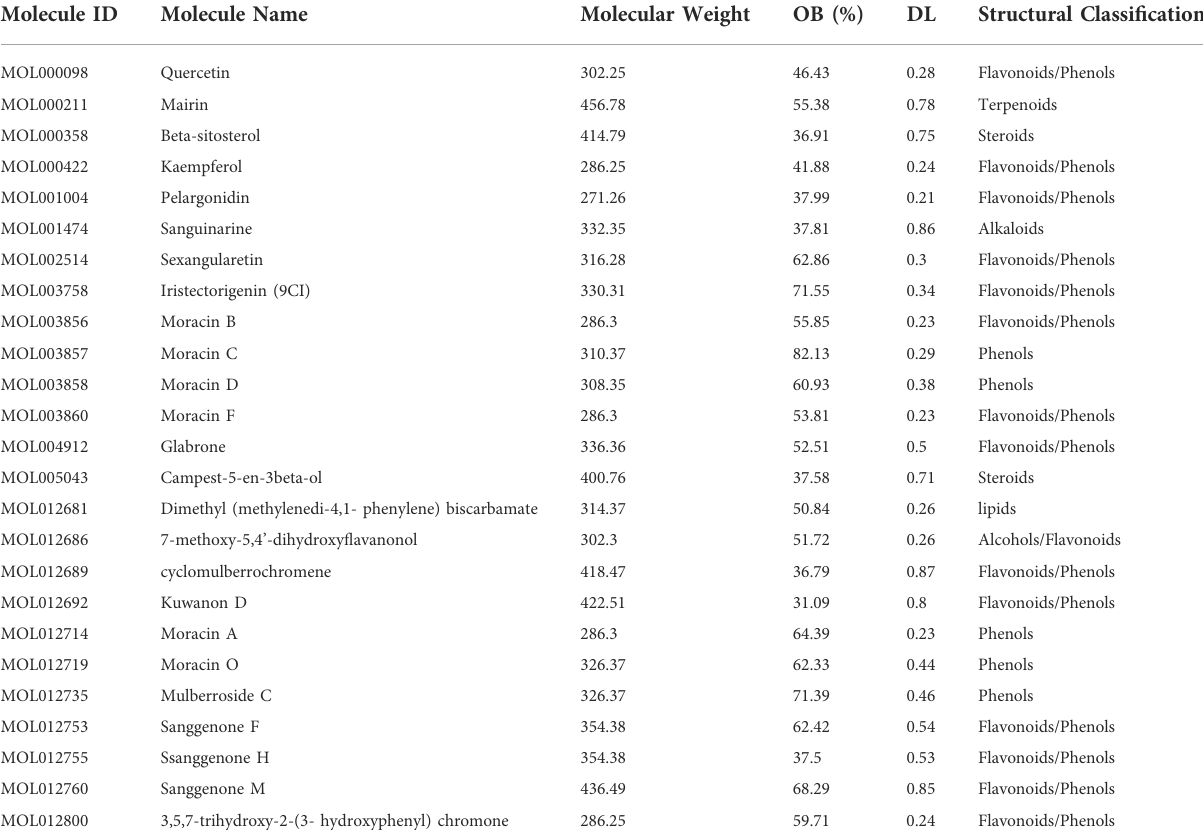
TABLE 1 Characteristics of active ingredients in Mori Cortex